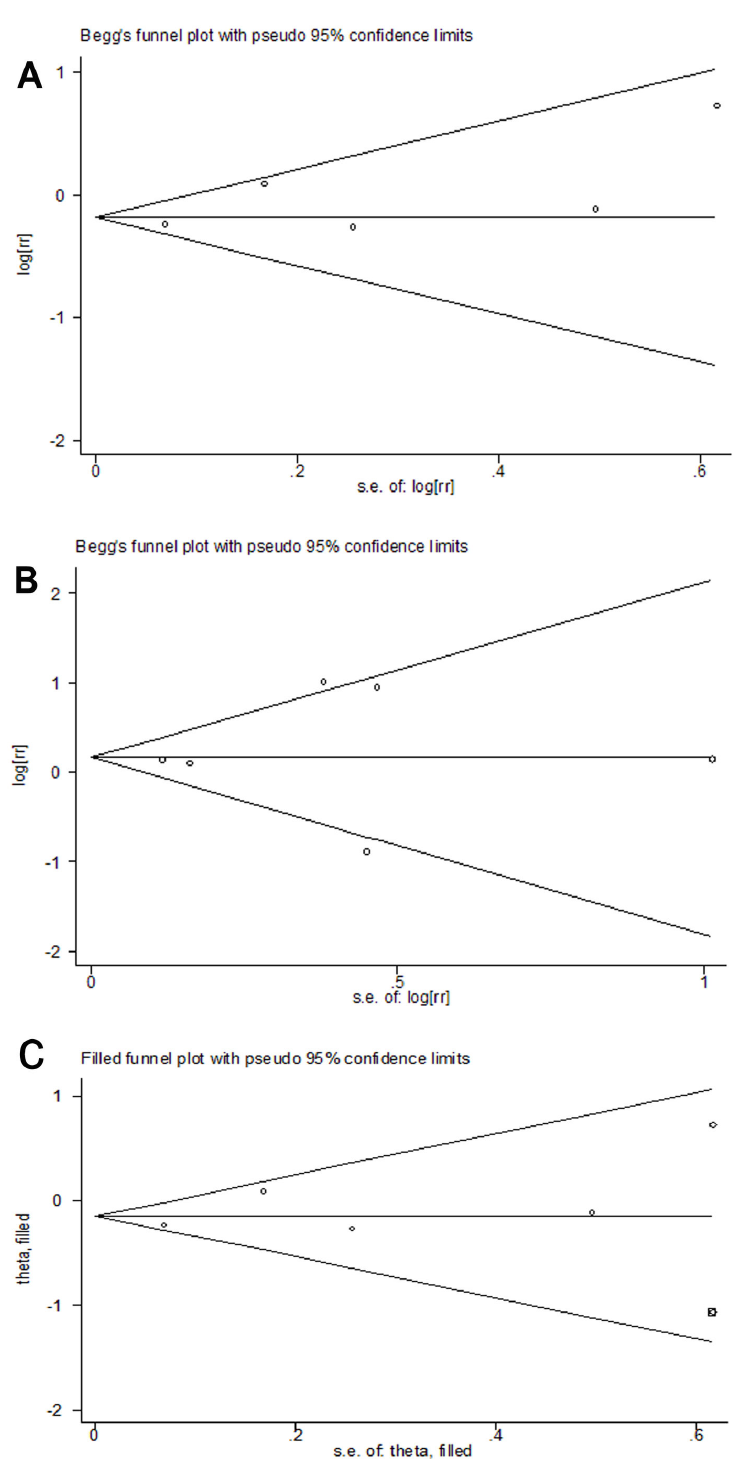
Figure 4. Funnel plots for publication bias. A: Funnel plot for studies investigating insulin vs. other glucose-lowering agents and risk of prostate cancer. No publication bias was observed ( P investigating insulin glargine vs. non-glargine and risk of prostate cancer. No publication bias was observed ( P P = 0.718). C: Filled funnel plot of comparison of insulin vs. other glucose-lowering therapies and risk of prostate cancer. The Egger’s test filled diamonds represent one presumed missing study. doi: 10.1371/journal.pone.0081594.g004 PLOS ONE |